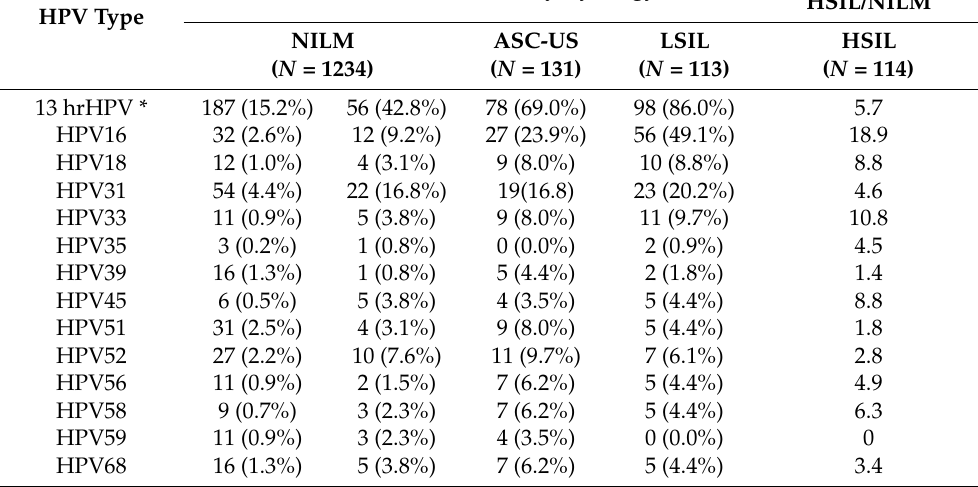
Table 1. Overall prevalence of hrHPV (aggregate of 13 types) and of individual hrHPV types detected by INNO-LiPA in the total study population according to baseline